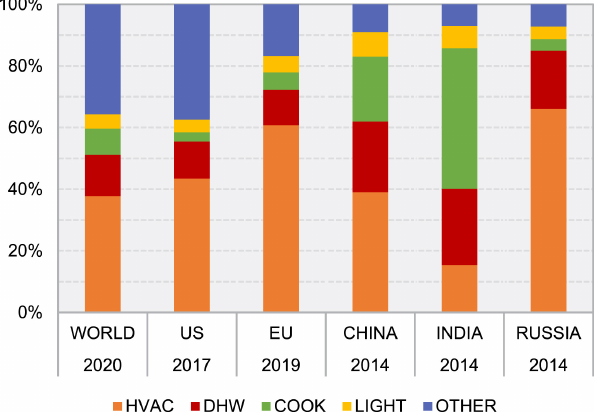
Figure 1. The share of HVAC system, Domestic Hot Water (DHW), lighting, cooking and other equipment in building consumption